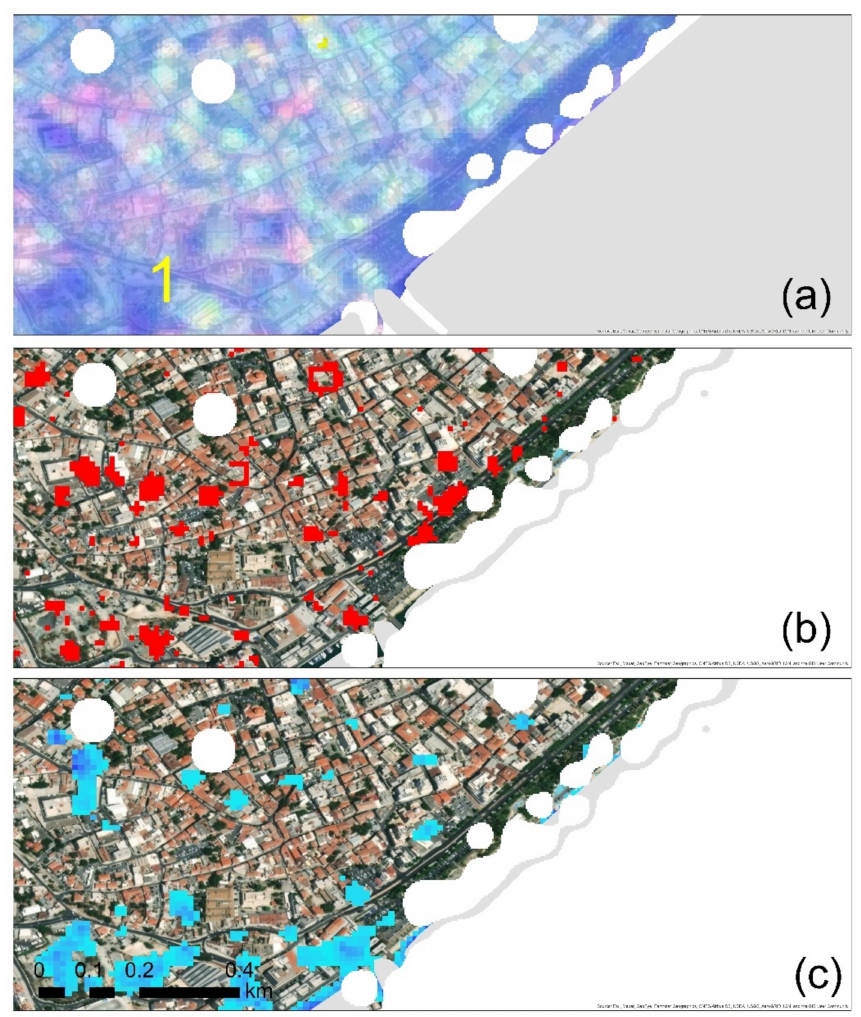
Figure 8. ( a ) VV and VH polarisations visualisation in Limassol centre. The bright colour indicates changes within the observation period; ( b ) changes highlighted with red colour as recorded from the REACTIV algorithm for the same area as before; ( c ) cumulative changes using the statistical analysis. Non-urban areas as classified from the optical Sentinel-2 image, using the random forest classifier, are shown with white colour. The specific area mentioned in the text is shown with